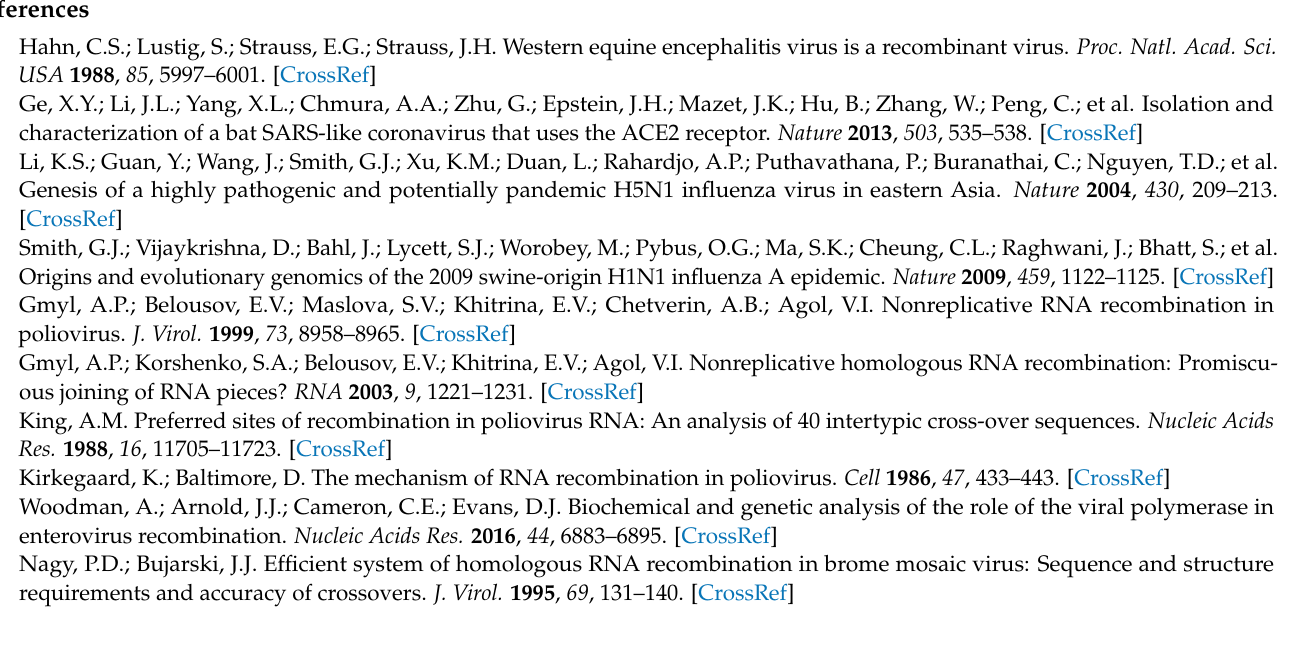
Table S1: CRE-REP sequence identity analysis; Figure S2: Recombination junction definition; Table S2: Sanger Sequencing of recombinants generated from co-infection; Figure S3: Alignment of CRE-REP modified sequences; Figure S4: replication kinetics of CRE-REP modified sequences; Figure S5: RNA quantification of CRE-REP assays; Figure S6: NGS analysis of the co-infection technical